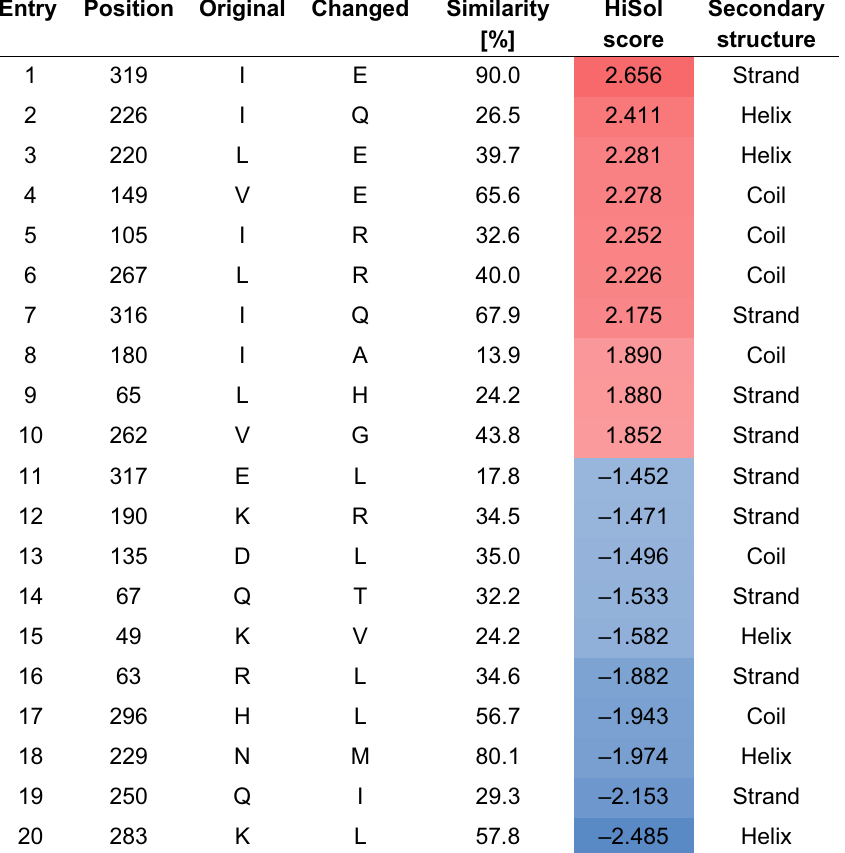
Table 1. Predicted mutation sites in the sequence of OxdB by the program INTMSAlign_HiSol 36 . The structure elements were predicted by PSIPRED 37,38